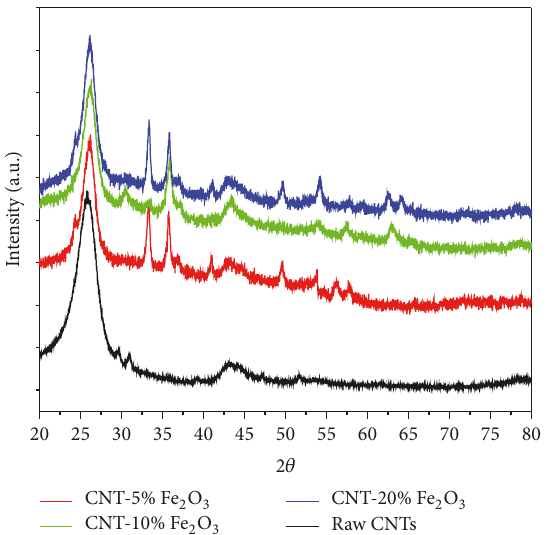
Figure 1: XRD analysis of raw CNTs, and CNT-5% iron oxide, CNT- 10% iron oxide, and CNT-20% iron